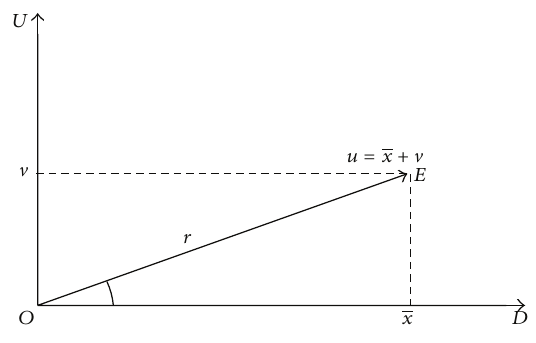
deviation) V of the connection number 𝑢(𝑥, V ) can be mapped to the binary determinacy-uncertainty space ( D-U space) based on SPA. If 𝑢(𝑥, 𝑠) = 𝑥 + V 𝑖 represents the vector of D- U space, then the “ 𝑖 ” only denotes the signal of the uncertain term without representing the changeable value [2]. Figure 1 is a D-U space. The 𝑈 axis and the 𝐷 axis represent the relative uncertain measure and the relative deterministic measure, respectively. In Figure 1, the 𝑥 and the V interact with each other, and the space reflection is the vector 𝑂𝐸 from 𝑂 to 𝐸 , and the degree of interaction means the module of the vector 𝑂𝐸 denoted by 𝑟 [6].